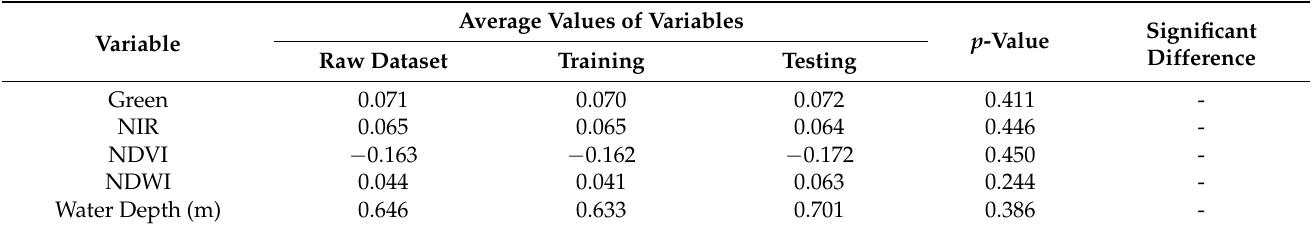
Table 3. Significance test between training dataset ( n = 138) and testing dataset ( n =